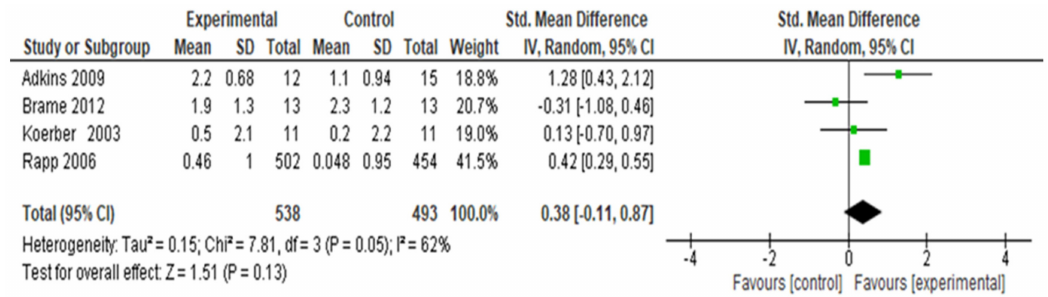
Figure 6. Forest plot for change in students’ self-e ffi cacy in tobacco cessation counseling.